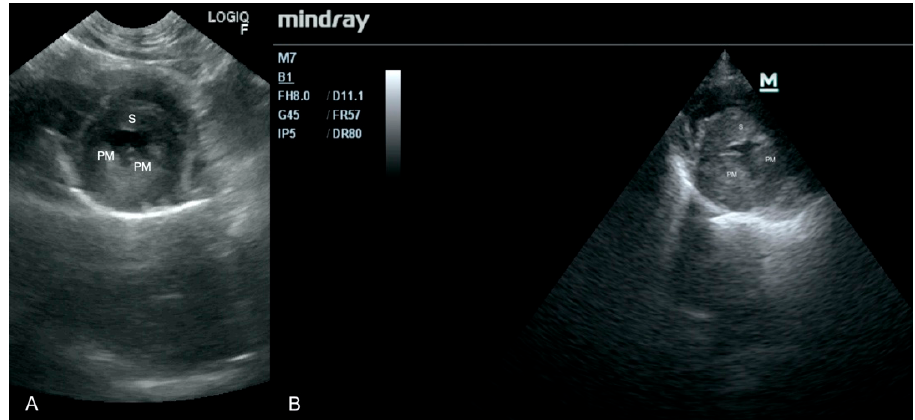
Figure 3. Thickening of left ventricle walls. PM—papillary muscle, S—septum. ( A ) Scan from a microconvex probe obtained during focused cardiac ultrasound examination (GE Healthcare Logiq F6). ( B ) Scan from phased array probe obtained during echocardiography examination performed by a board-certified echocardiography specialist (Mindray M7).